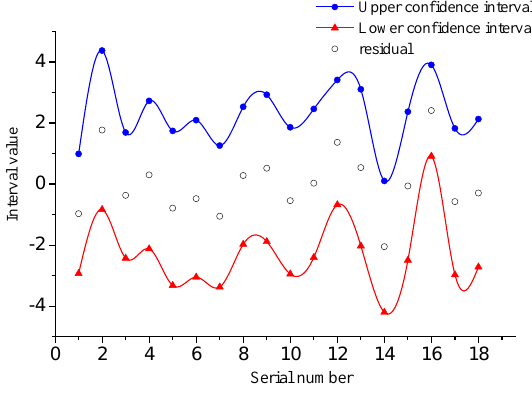
Figure 6. Residual confidence interval.